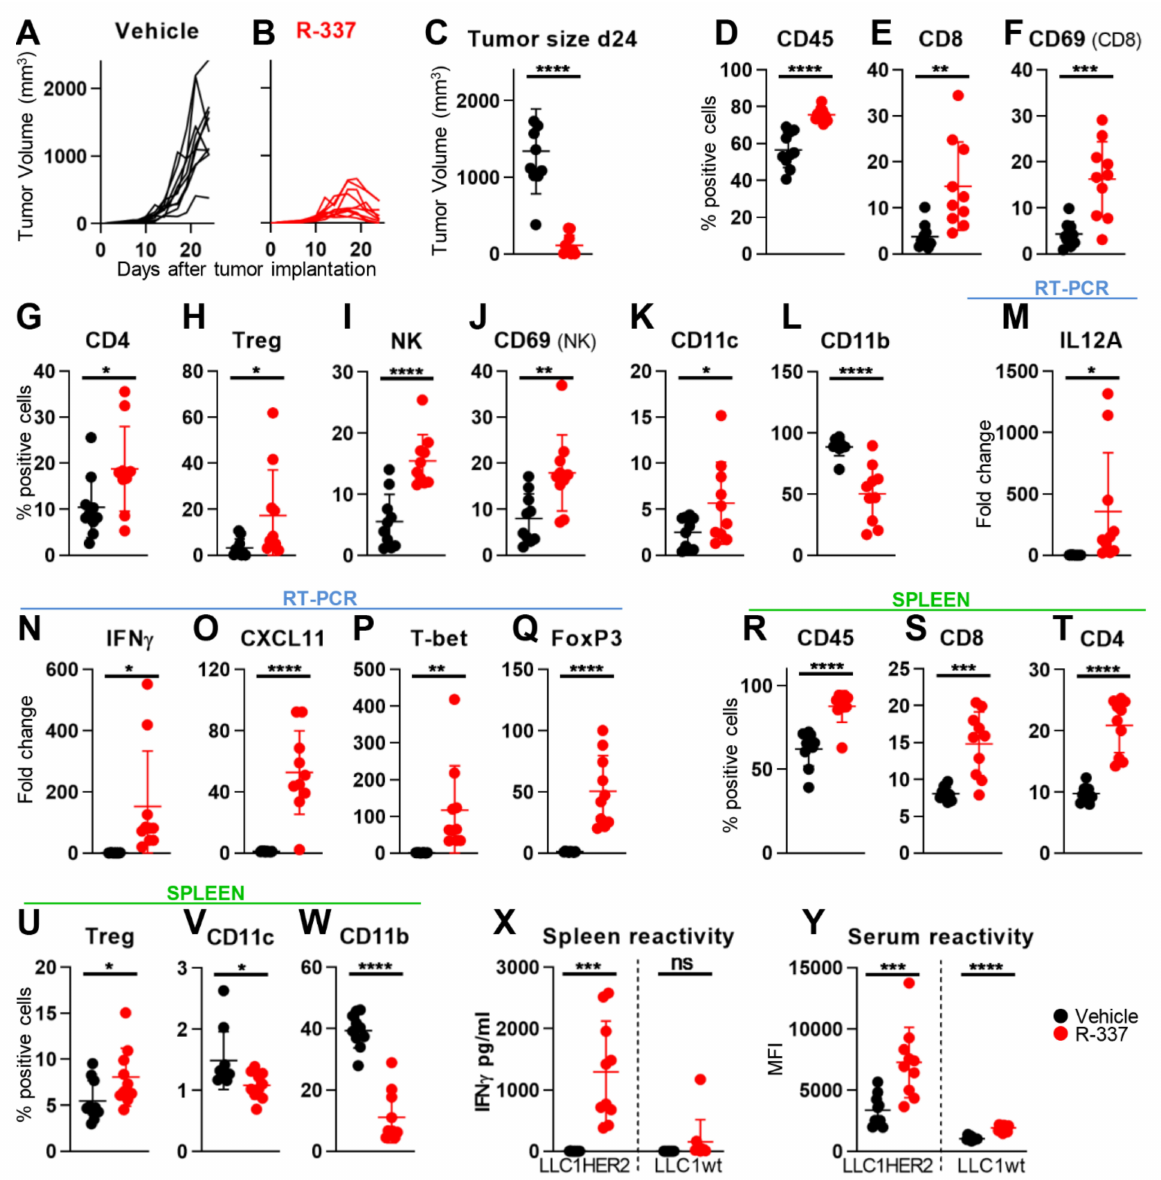
Figure 5. Immune heating of TME and spleen modifications induced by intratumoral R-337 monotherapy. ( A , B ) Kinetics of tumor growth in HER2-TG C57BL/6 mice treated with vehicle ( A ) or R-337 ( B ), according to the schedule reported in Figure 4A. ( C ) Tumor volumes at d 24. Black (vehicle) and red (R-337) circles. ( D – L ) Immune cell populations in tumors. Single cell suspensions were prepared from freshly isolated LLC1-HER2 tumors at sacrifice. Tumors were minced in small pieces, digested with collagenase, passed through 70 µ m cell strainer and rinsed with FACS buffer. For each sample, 2 × 10 6 cells were blocked with α -CD16/32 Ab (clone 93), and then reacted with the antibodies CD4-FITC (clone GK1.5), CD8a-PE (clone 53-6.7), CD45-Percp-Cy7 (clone 30-F11), CD335-APC (clone 29A1.4), FoxP3-PE (clone 150d/e4), CD11b-FITC (clone M1/70), CD11c-PE (clone N418) and CD69-PercP (clone H1-2F3). Data were acquired on BD C6 Accuri. CD4 (CD4+ cells), CD8 (CD8+ cells), NK (CD335+ cells) and myeloid cells (CD11b+ cells) were gated on CD45+